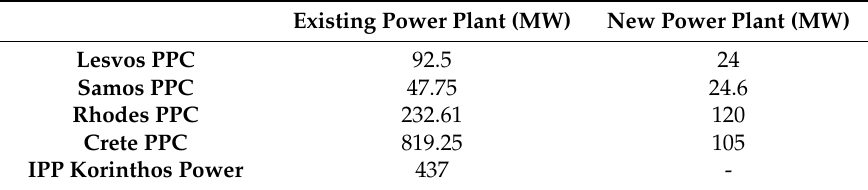
Table 4. Existing and New Power Plants